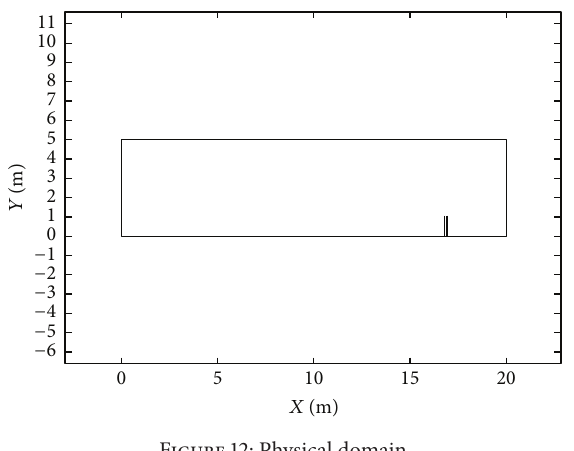
Figure 12: Physical